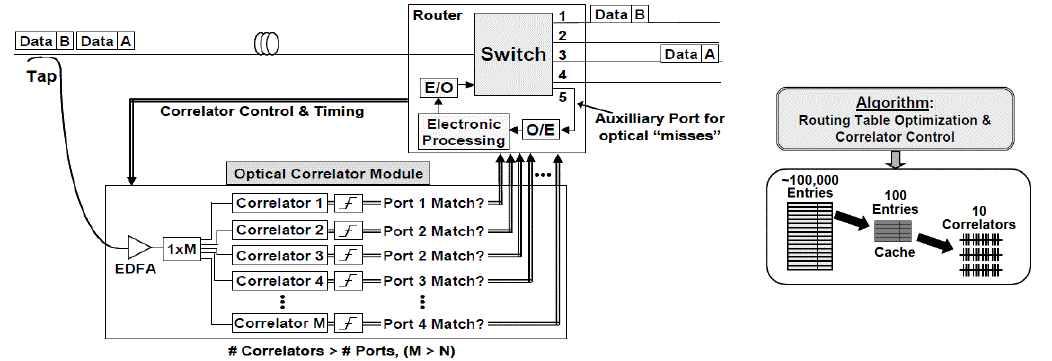
Figure 3. Optical header lookup as a pattern matching operation ( left ); distilling full routing to 10 correlators ( right ).